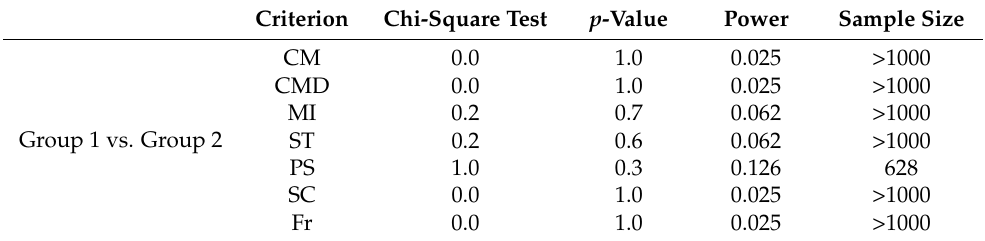
Table 4. Results of a log-rank test for comparing long-term results after SCR between two groups: those with the absence of biological factors of caries risk (Group 1) and the presence of biological factors of caries risk (Group 2).